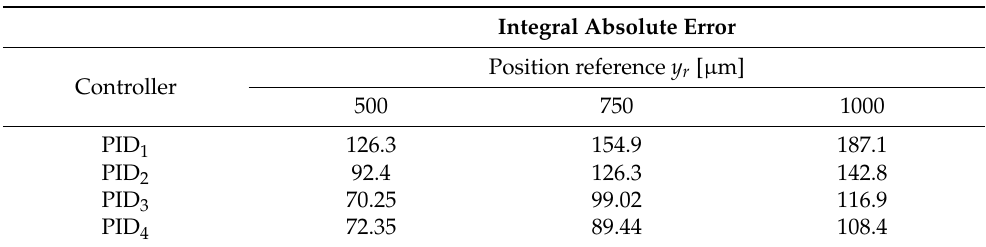
Table 7. Integral absolute error.